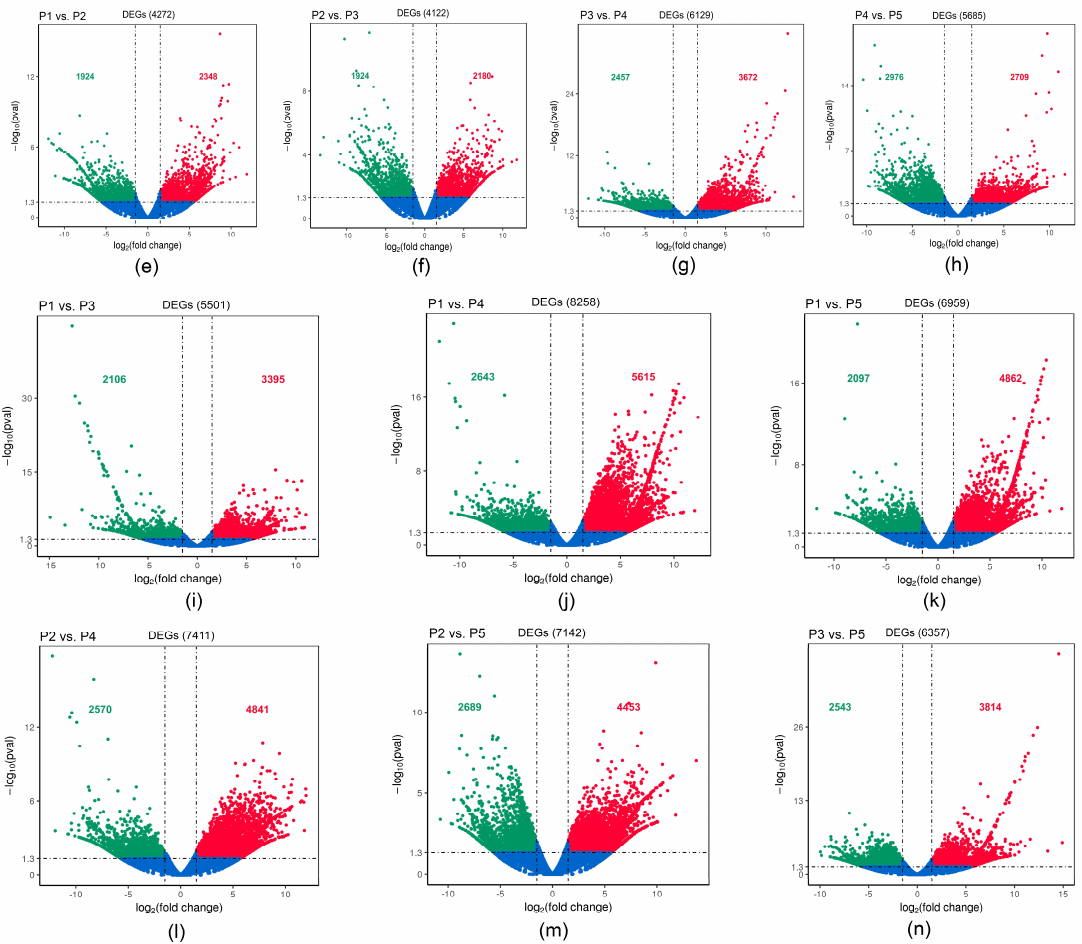
Figure 1. The samples subjected to RNA-Seq and the numbers of differentially expressed genes (DEGs) for the samples: ( a ) external morphology of the bulb; ( b ) sectional view of the internal organi- zational structure of the bulb (the samples were collected from the meristem site); ( c ) morphological characteristics of the five samples. P1 − P3: 1 − 3-year-old bulbs that cannot flower, P4 − P5: 4-year-old nonflowering and flowering bulbs, respectively. ( d ) Venn diagram of the DEGs in combinations of P1 vs. P2, P2 vs. P3, P3 vs. P4, and P4 vs. P5. ( e – n ) The volcano plots show the number of DEGs for each combination of different